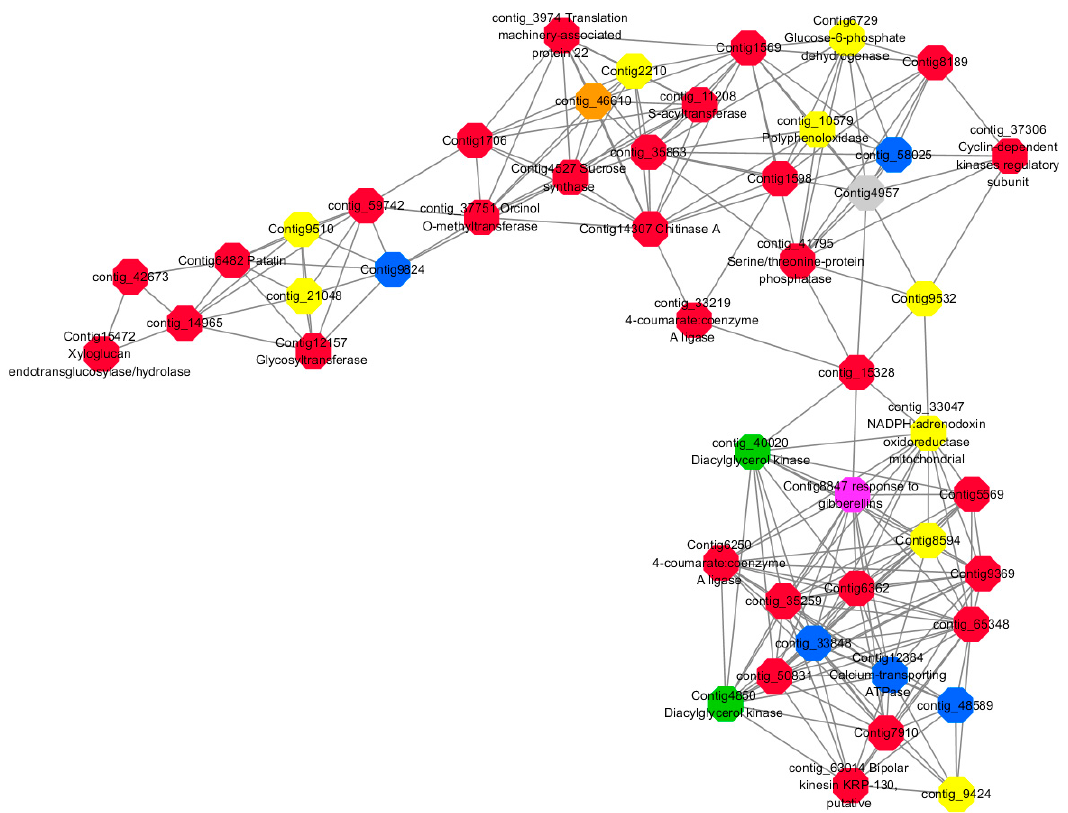
Figure 25. Interaction between genes in Module 2.